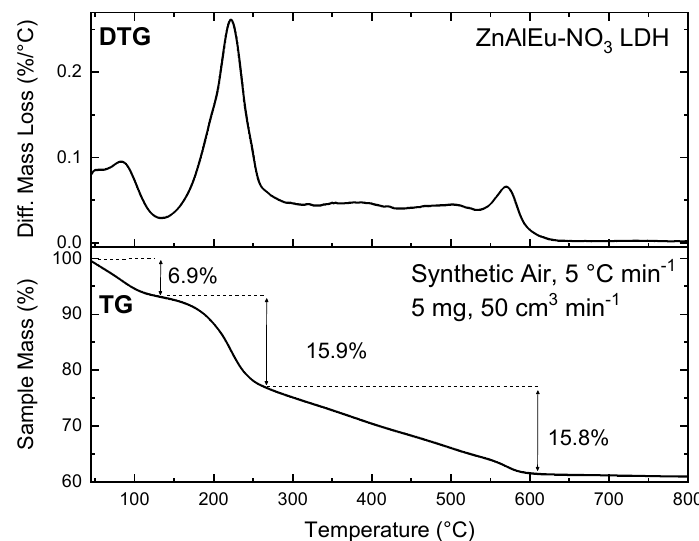
Figure 3. Thermogravimetric analysis of the ZnAlEu–NO 3 LDHs. Crystals 2019 , 9 , x FOR PEER